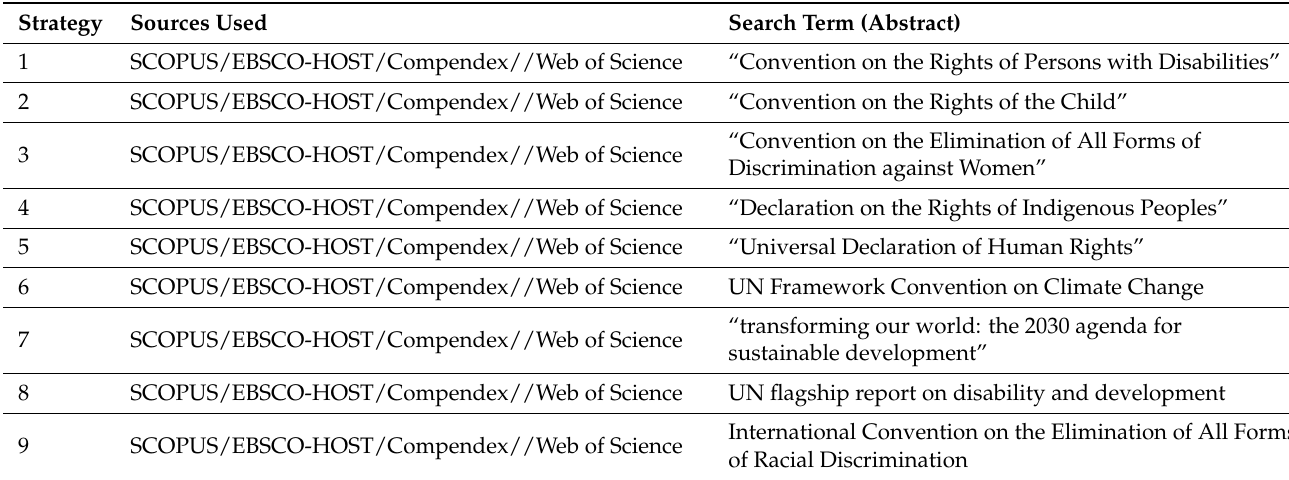
Table 1. Search strategies used to obtain academic abstracts for quantitative hit counts.